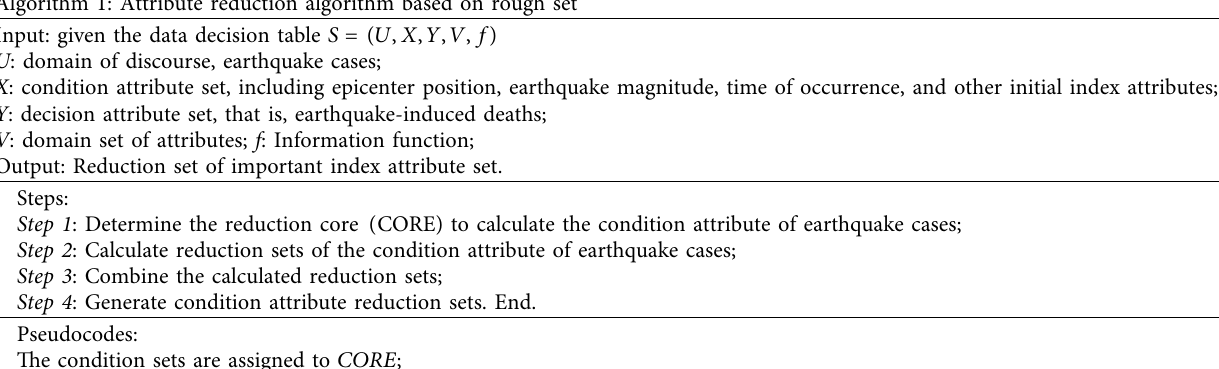
Table 2: Steps and pseudocodes of reduction algorithms. Algorithm 1: Attribute reduction algorithm based on rough